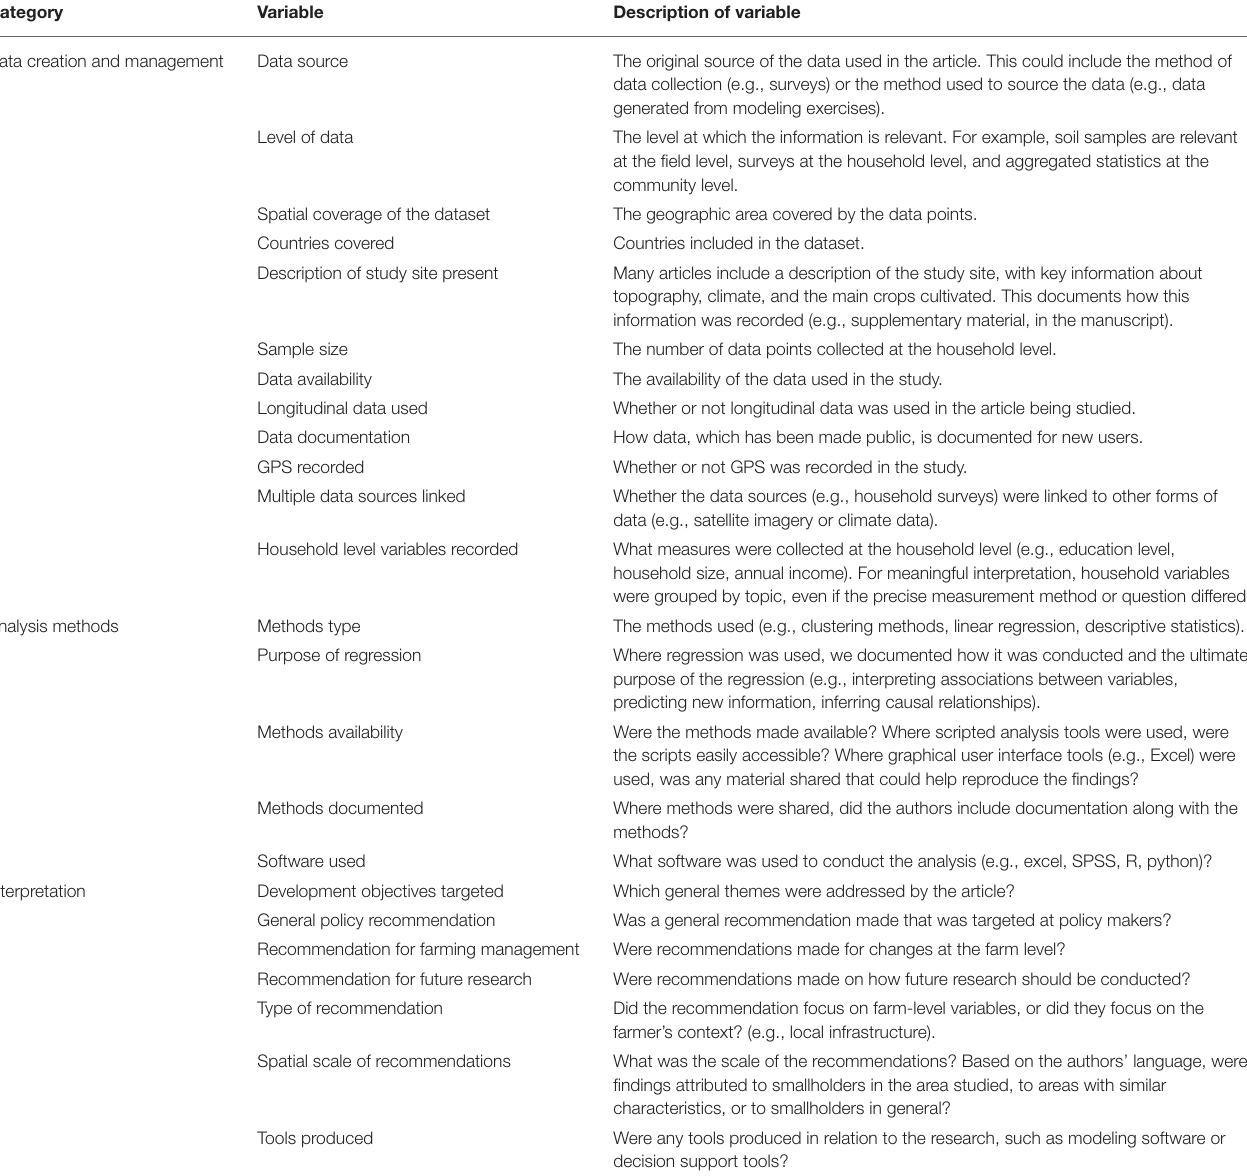
TABLE 2 | The criteria used to evaluate full articles. Category